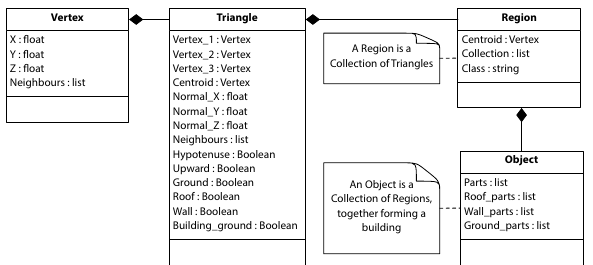
Figure 4: UML diagram or our structure. The list in Vertices contains the neighbours—the vertices that are within the distance range of the set threshold.